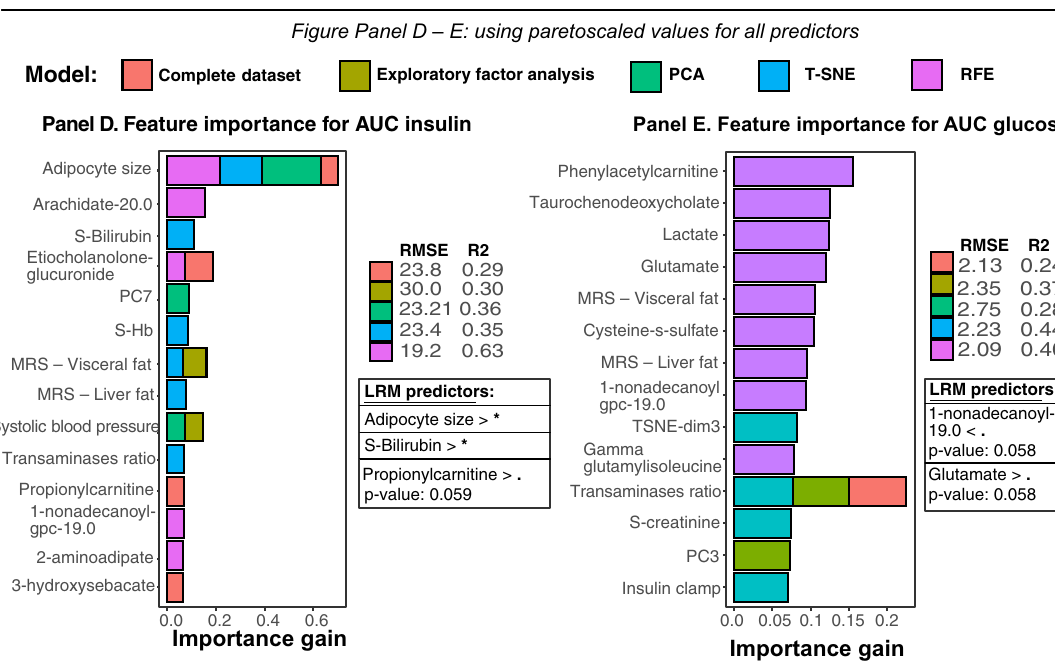
Figure 2. Distribution and area under curve for oral-glucose tolerance test of insulin and glucose, as well as feature importance for constructed variables based on extreme gradient boosting models and linear regression. Panel ( A )–( B ) shows distributions for insulin and glucose related OGTT variables that were used to generate AUC variables for insulin and glucose. Panel C shows association between AUC insulin and AUC glucose, along with correlation coefficient. In Panel ( D )–( E ), relative importance for predictors generated by extreme gradient boosting models, using pre-processing techniques for metabolomics data to reduce number of predictors in the final model. Model diagnostics ( RMSE ) and validation ( R 2 ) are presented next to each prediction model. The most important predictors identified through prediction modeling were included in a linear regression model. Significance level are described as follows: * p -value < 0.05, p -values < 0.06. < denotes that lower levels for the predictor was associated with the target variable. > denotes that higher levels for the predictor was associated with the target